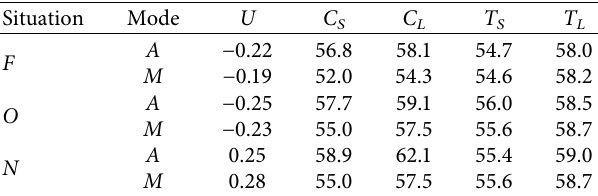
Table 11: Transportation plans with different transportation